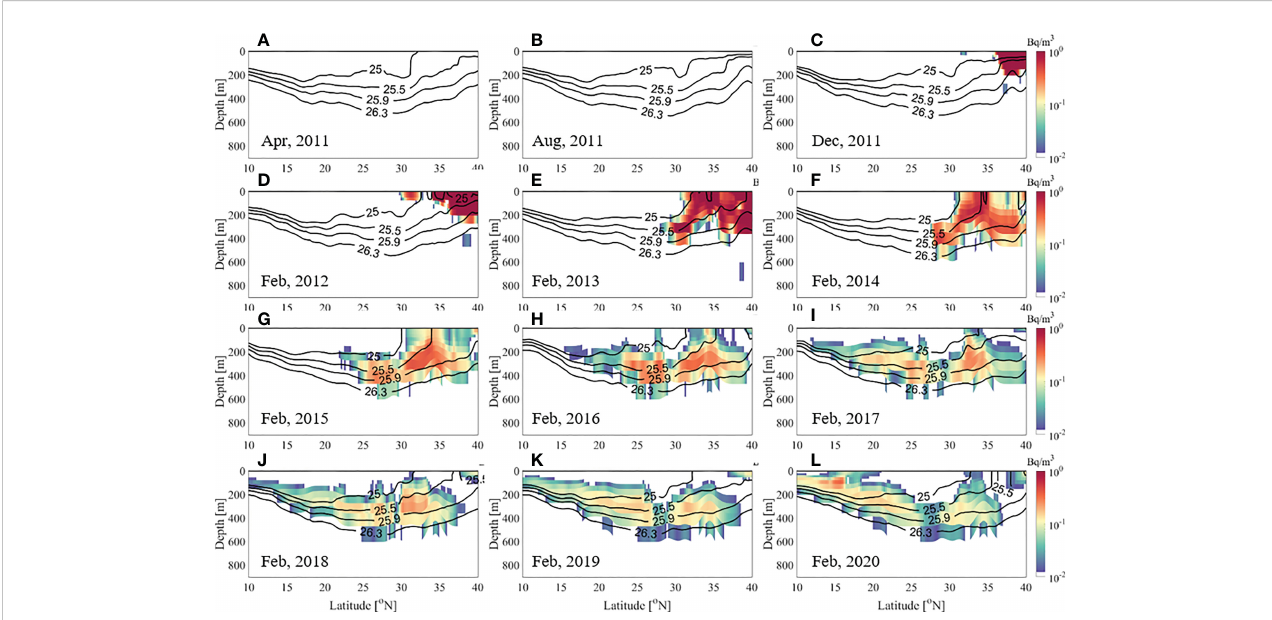
FIGURE 8 Monthly vertical sections of 137 Cs concentration along line L2 (180°E) in April (A – C) , August and December 2011 and each February (D – L) from 2012 to 2020. The background contour represents the potential density (kg/m 3 ). 137 Cs concentration was corrected for radioactive decay (30